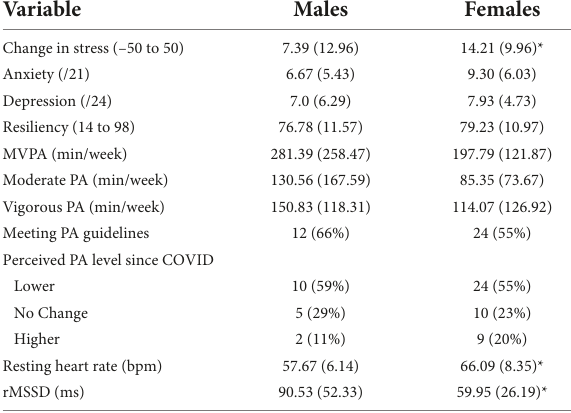
Table 6 . Biological sex explained 14% of variance ( b = −